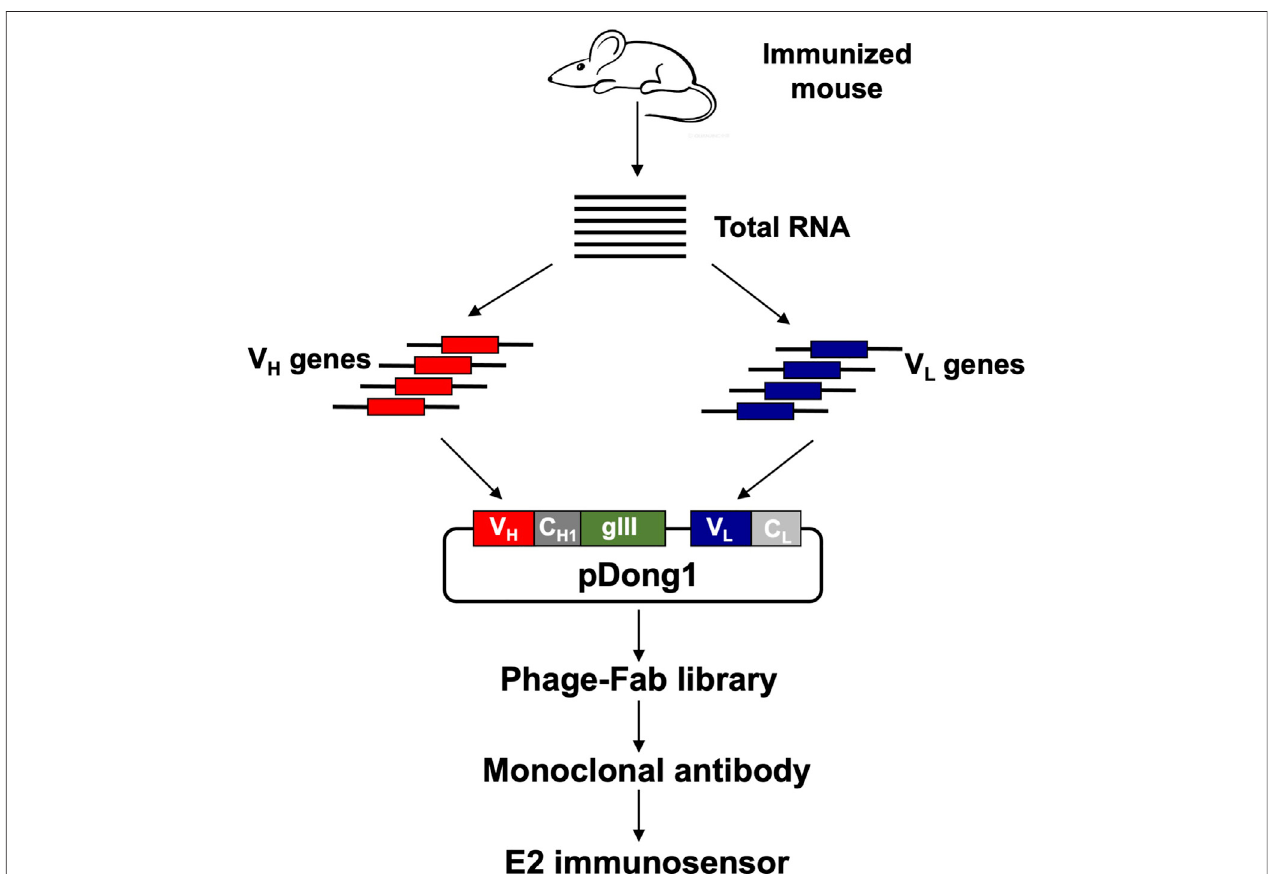
FIGURE 1 | Flow chart of antibody library construction and monoclonal antibody selection. V H : variable region of antibody heavy chain; V L : variable region of antibody light chain; C H1 : constant region 1 of heavy chain; C L : constant region of light